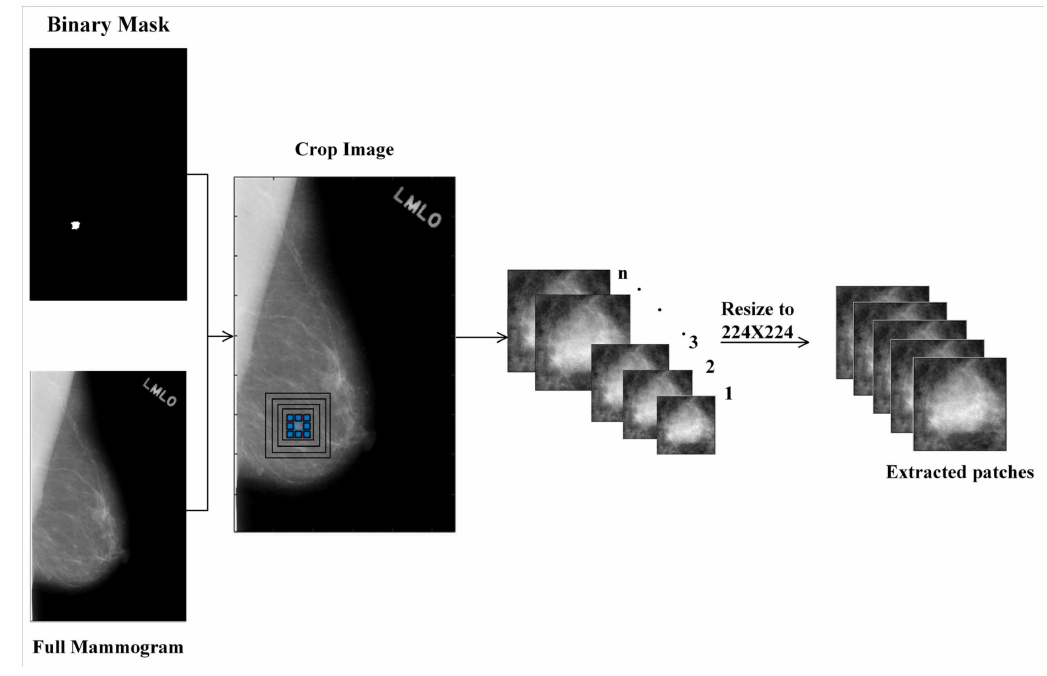
Figure 13. Extracted ROI with different